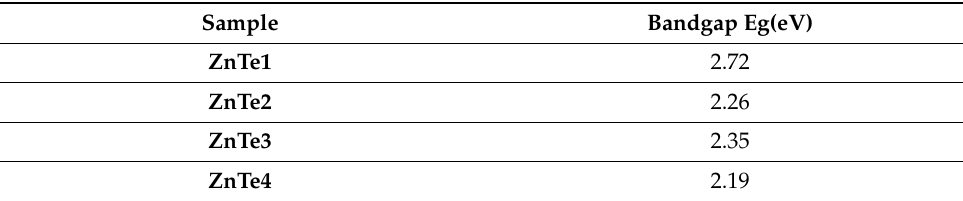
Table 4. Bandgap values.